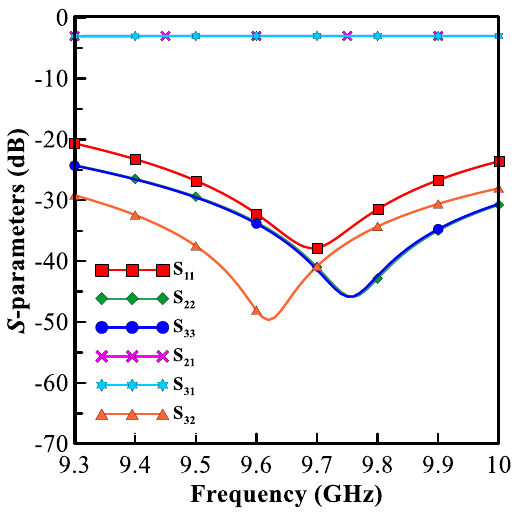
Figure 9: Structure of the waveguide-to-microstrip transition with a SMA-to-waveguide adapter.